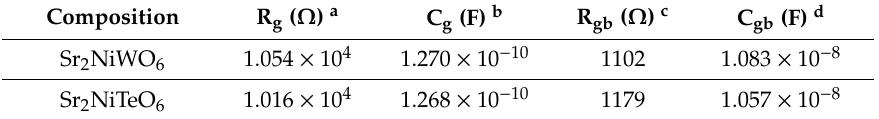
Figure 7. Nyquist plot of ( a ) Sr 2 NiWO 6 and ( b ) Sr 2 NiTeO 6 ceramics at room temperature. In the inset, the equivalent electrical circuits are displayed. Table 5. The values of grain resistance and grain capacitance from the Nyquist plot fitting.